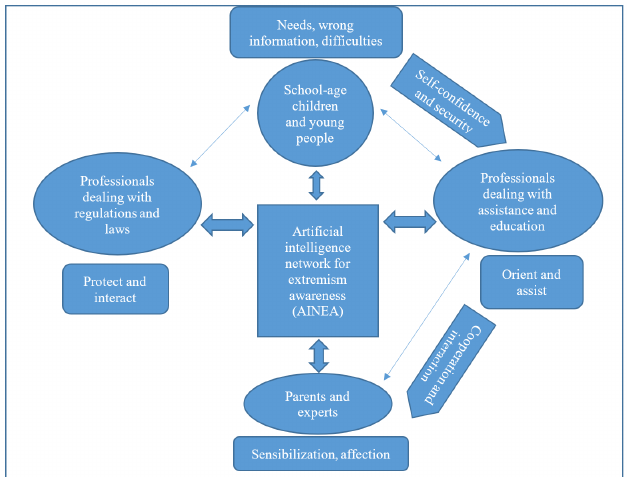
Fig. 1. A primary conception of AINEA platform Source: Our literature